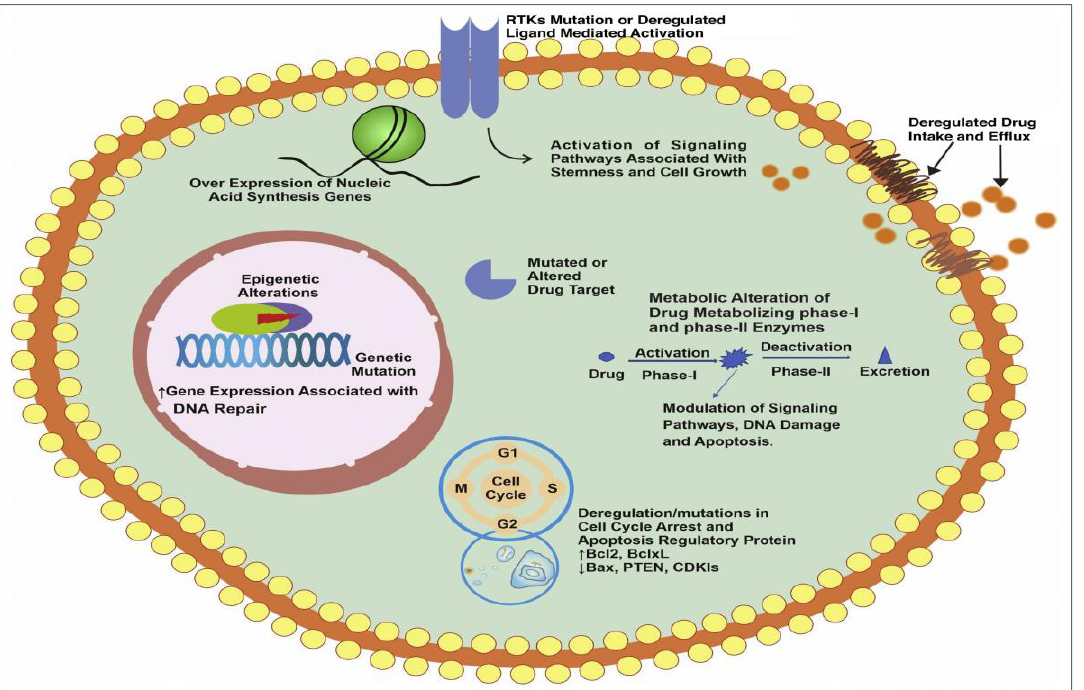
Figure 3. Different underlying mechanisms associated with drug resistance. This figure shows different intrinsic and extrinsic factors responsible for cancer drug resistance starting from alteration of signaling pathways, remodeling of drug efflux pumps expression, overexpression of genes related to cell cycle and apoptosis, enhanced expression of nucleic acid synthesis genes, enhanced DNA repair ability, alteration of drug target sites, alteration in functioning of drug metabolizing enzymes, genetic alternations, and epigenetics. Reproduced from Ref. [40], (2022), with permission from Elsevier. Table 1. A representative list showing different mechanisms along with drugs, molecular targets, and cancer type associated with cancer drug resistance.